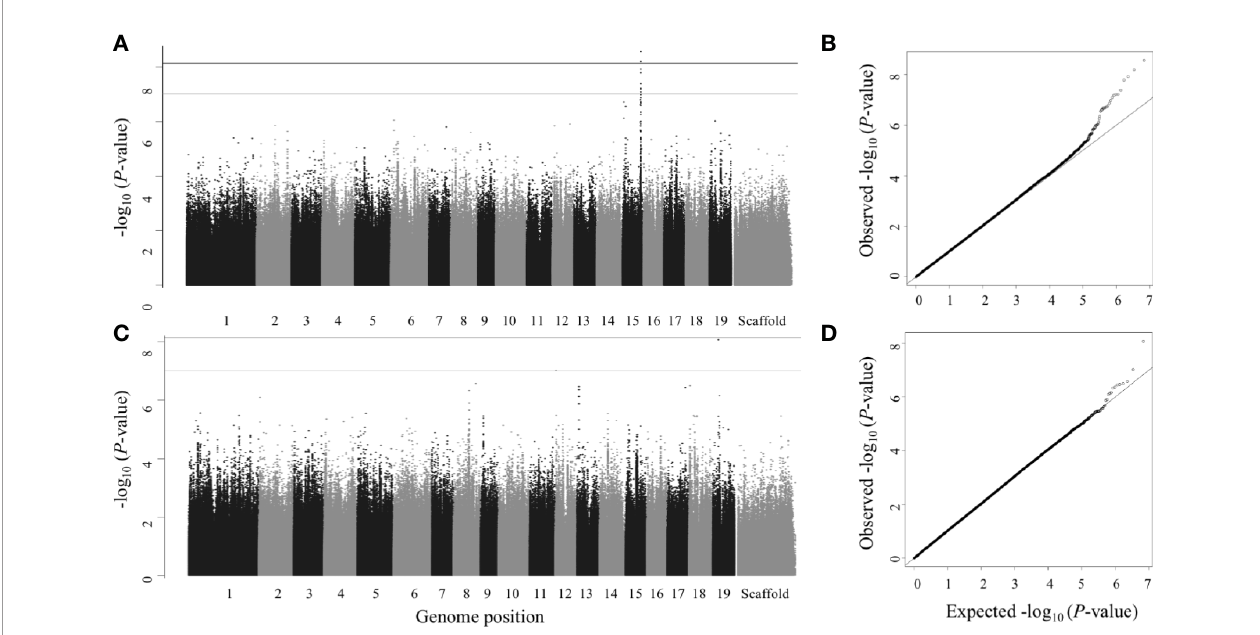
FIGURE 4 | Single trait GWAS – Manhattan (left) and QQ plots (right). Numbers 1 to 19 represent chromosomes; scaffolds are the reads that did not align to any of the 19 chromosomes. (A , B) Stomatal density; (C , D) Vessel size (intermediate wood). SNPs above gray line have p <1×10 -7 , which is roughly equivalent to FDR ≤ 0.1 and SNPs above black line (the top line) have p <7.417×10 -9 (the Bonferroni correction threshold), which is roughly equivalent to FDR ≤ 0.05 in this study.